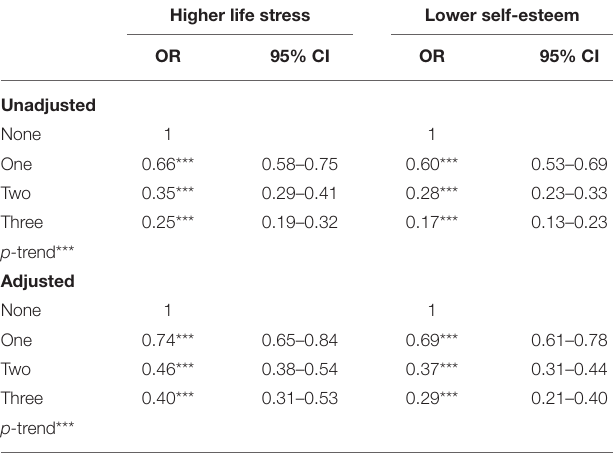
TABLE 3 | Results of the ordered logistic regression analysis of the associations of number of movement behavior recommendations met with life stress and self-esteem among adolescents ( N = 6,932).